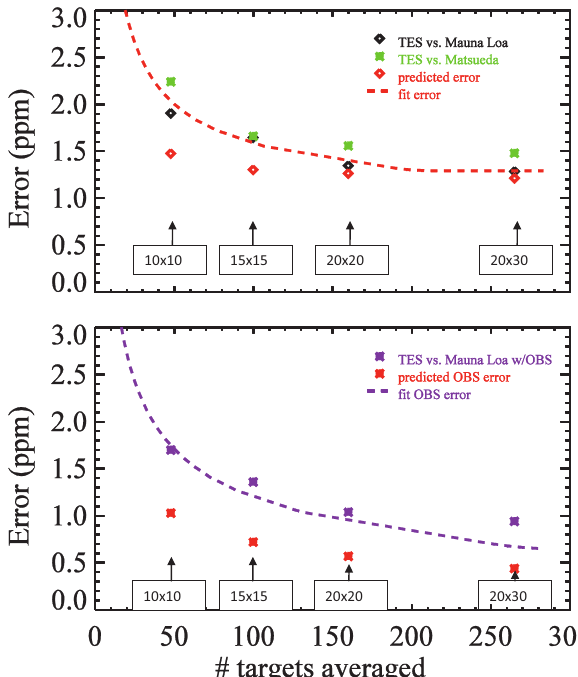
Fig. 7. Actual and predicted total error (top panel) and observation error (bottom panel). The actual error is the root mean square dif- ference between TES and in situ data. As predicted, comparisons to in situ data improve as the number of profiles averaged increases. The actual error fits best to an observation error of 12ppm (about twice the predicted observation error) and a self-smoothing error of 1.1ppm (as predicted). This fit is shown as a red dashed line in both